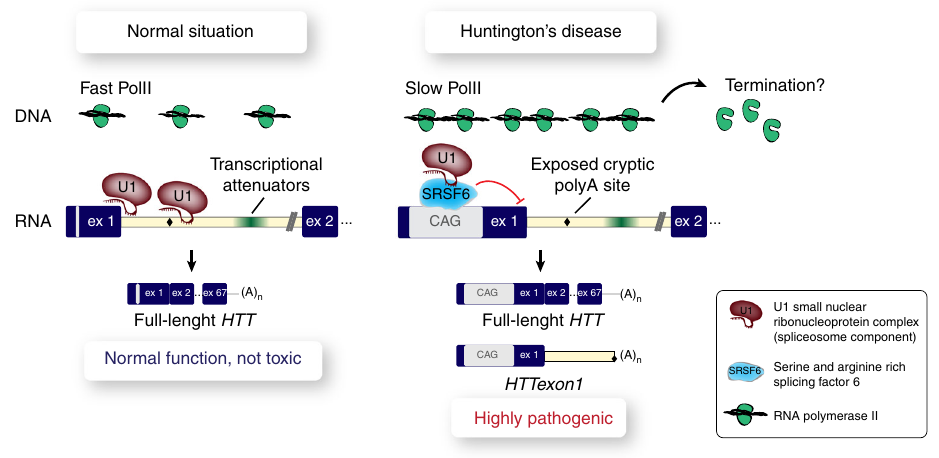
Fig. 7 Schematic depicting mechanisms in fl uencing incomplete splicing of HTT in HD. In the normal situation (left panel), U1 snRNP protects cryptic polyA sites from being utilized and de fi nes the 5 ′ splice site at the exon 1/intron 1 junction. Transcription by PolII is fast and thus HTT is properly spliced and the full-length mRNA is produced. In HD (right panel), there is an increased amount of SRSF6 binding to the elongated CAG repeat, which could sequester U1 snRNP resulting in interference with 5 ′ spliceosome formation and cryptic polyA site de-protection. In addition, transcription throughout the 5 ′ end of the gene is slower, kinetically allowing a higher probability of cryptic polyA site usage. Together, these mechanisms lead to the generation of HTTexon1